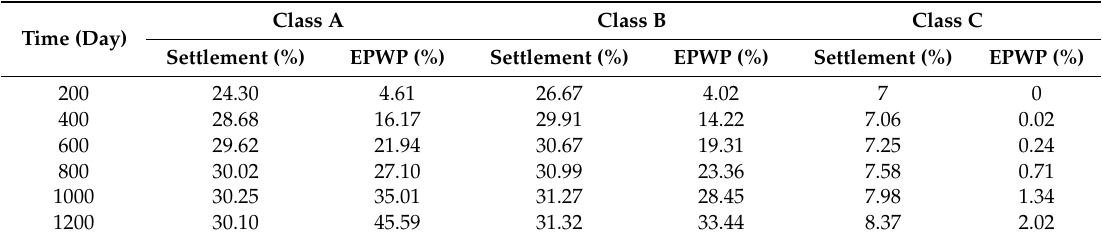
Table 3. Errors between results obtained using nonlinear and constant coe ffi cients at 2.5 m